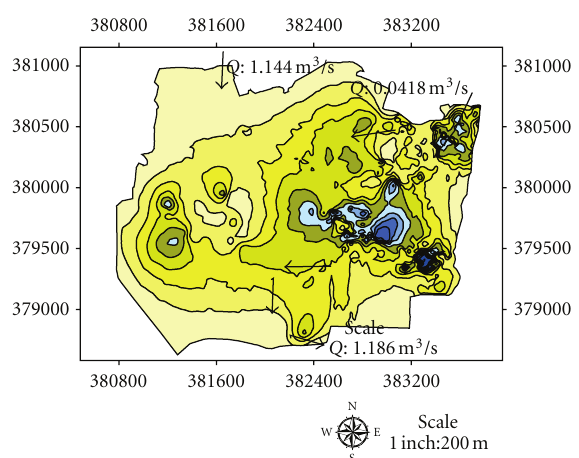
Figure 9: Complete map of the study area showing depth of studied lakes at the